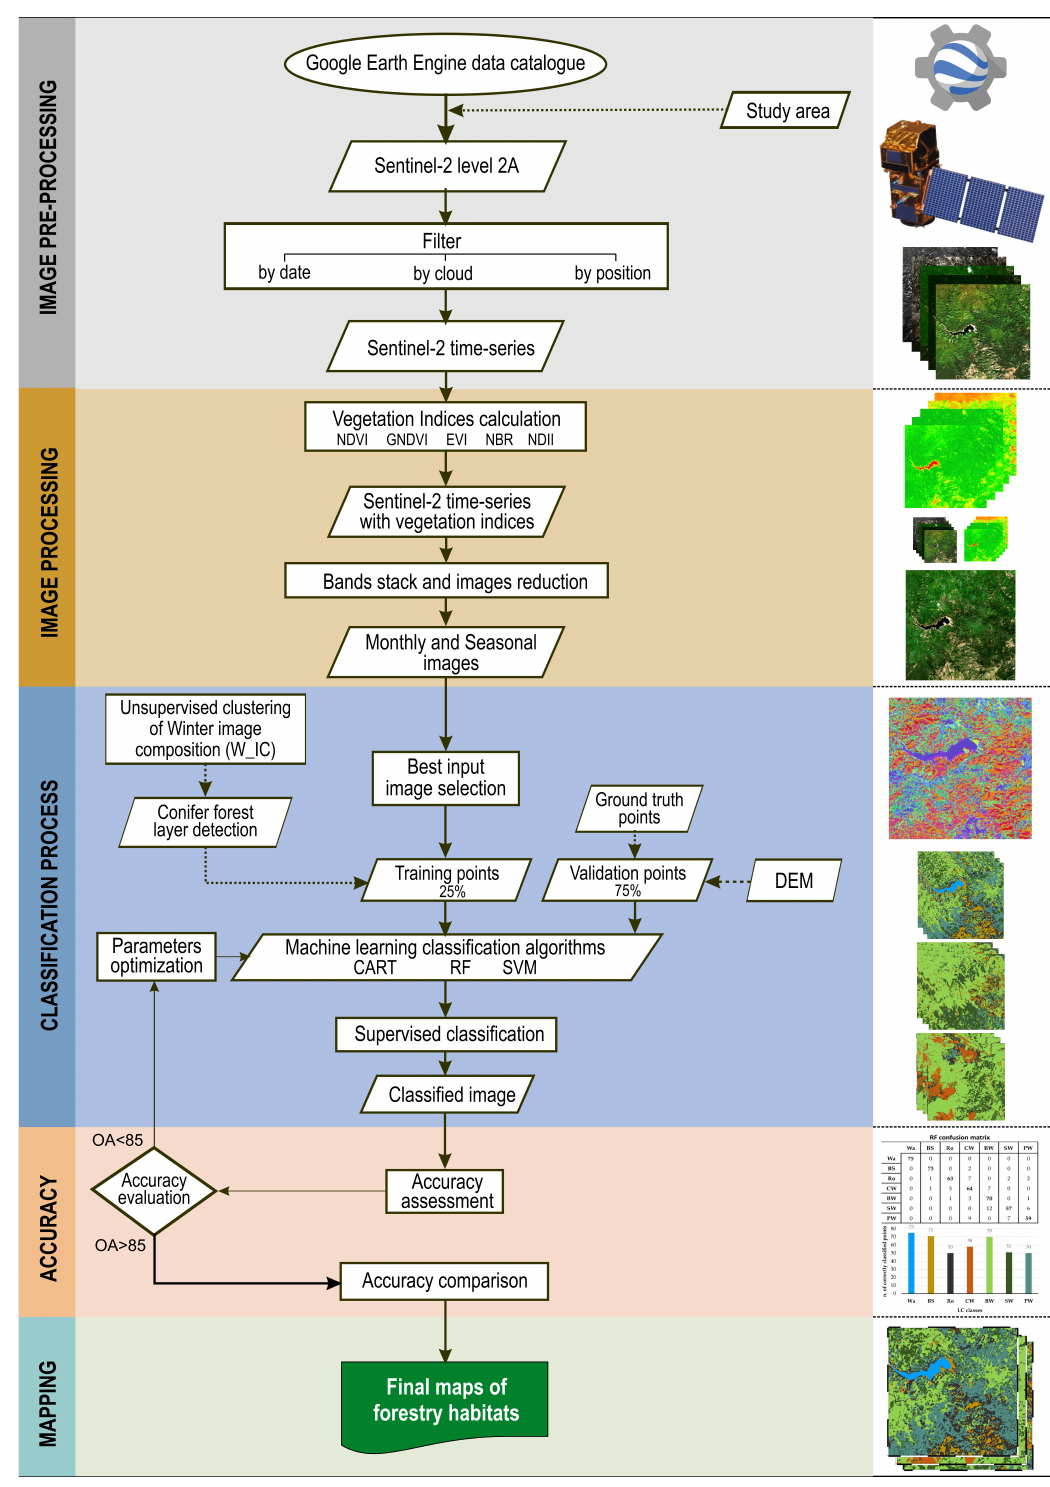
Figure 1. Workflow of the presented method. The first part shows the image pre-processing step to obtain the time-series. The second part shows all image processing steps to obtain image composites. The third part shows all the classification process components, while the fourth concerns the accuracy comparison step to obtain the final output (the last step). List of abbreviations: NDVI (normalised difference vegetation index); GNDVI (green normalised difference vegetation index); EVI (enhanced vegetation index); NBR (normalised burn ratio); NDII (normalised difference infrared index); DEM (digital elevation model); CART (classification and regression tree); RF (random forest); SVM (support vector machine); OA (overall